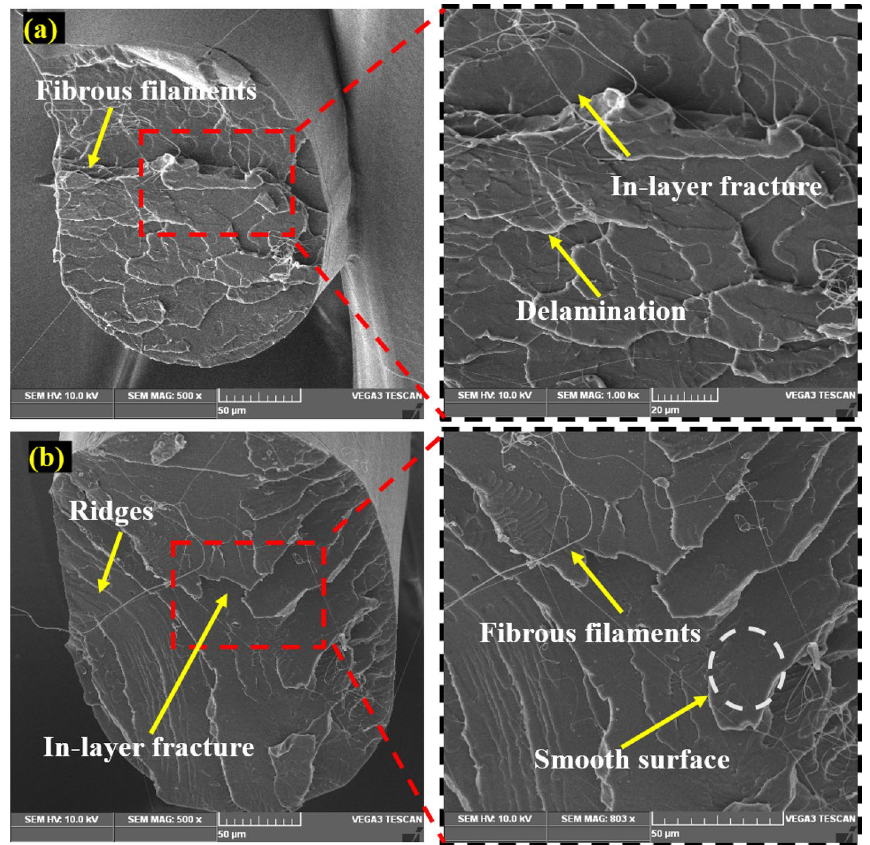
Figure 7. Microstructure of the tensile specimens ( a – b ) fracture surface under optimum input